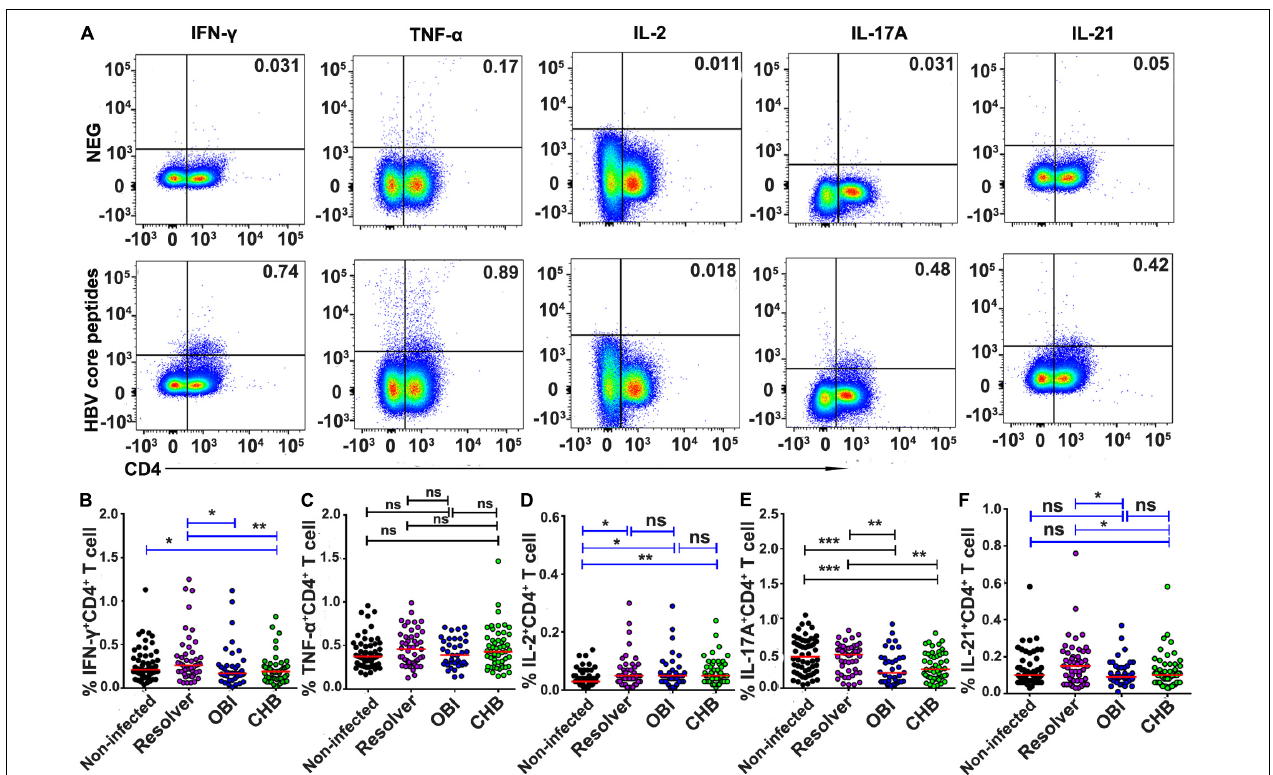
FIGURE 3 | Frequency of intracellular cytokine expressing CD4 + T cells after stimulation with HBV core peptides. PBMCs were freshly isolated from individual blood donors and measured by ICS for intracellular IFN- γ , TNF- α , IL-2, IL-17A, or IL-21 secreting CD4 + T-cell response, respectively, after simulation with core peptides for 6 h. (A) Representative flow-cytometric analysis of reactivity of CD4 + T cells from an OBI donor stimulated with negative control and HBV core peptides. (B–F) The frequency of various intracellular cytokine secreting CD4 + T-cell response is expressed as a mean of triplicates from each individual. A median of frequency in each group is indicated and the differences between groups are compared with the Mann–Whitney test. Statistically significant differences are shown with asterisks (* P < 0.05, ** P < 0.01, and *** P < 0.001); ns, no significant difference.